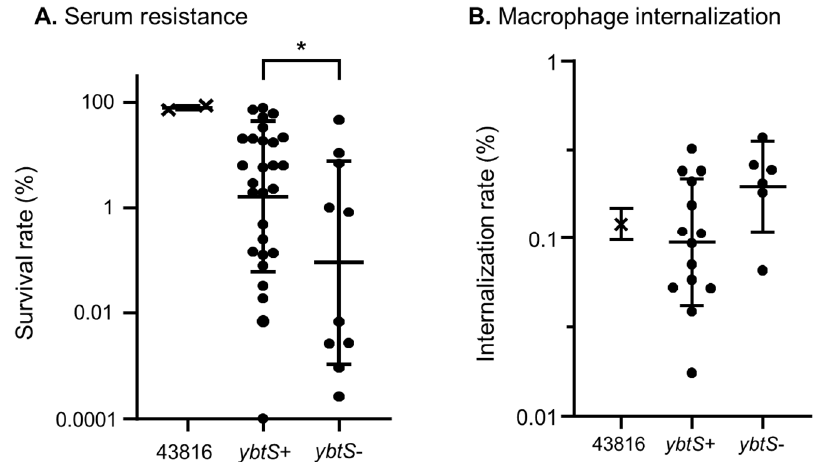
Figure 3. ( A ) Serum resistance and ( B ) macrophage internalization were compared between the ybtS ‐ positive and ‐ negative isolates regardless of clones. Student’s t ‐ test was used for statistical anal ‐ ysis. * p <